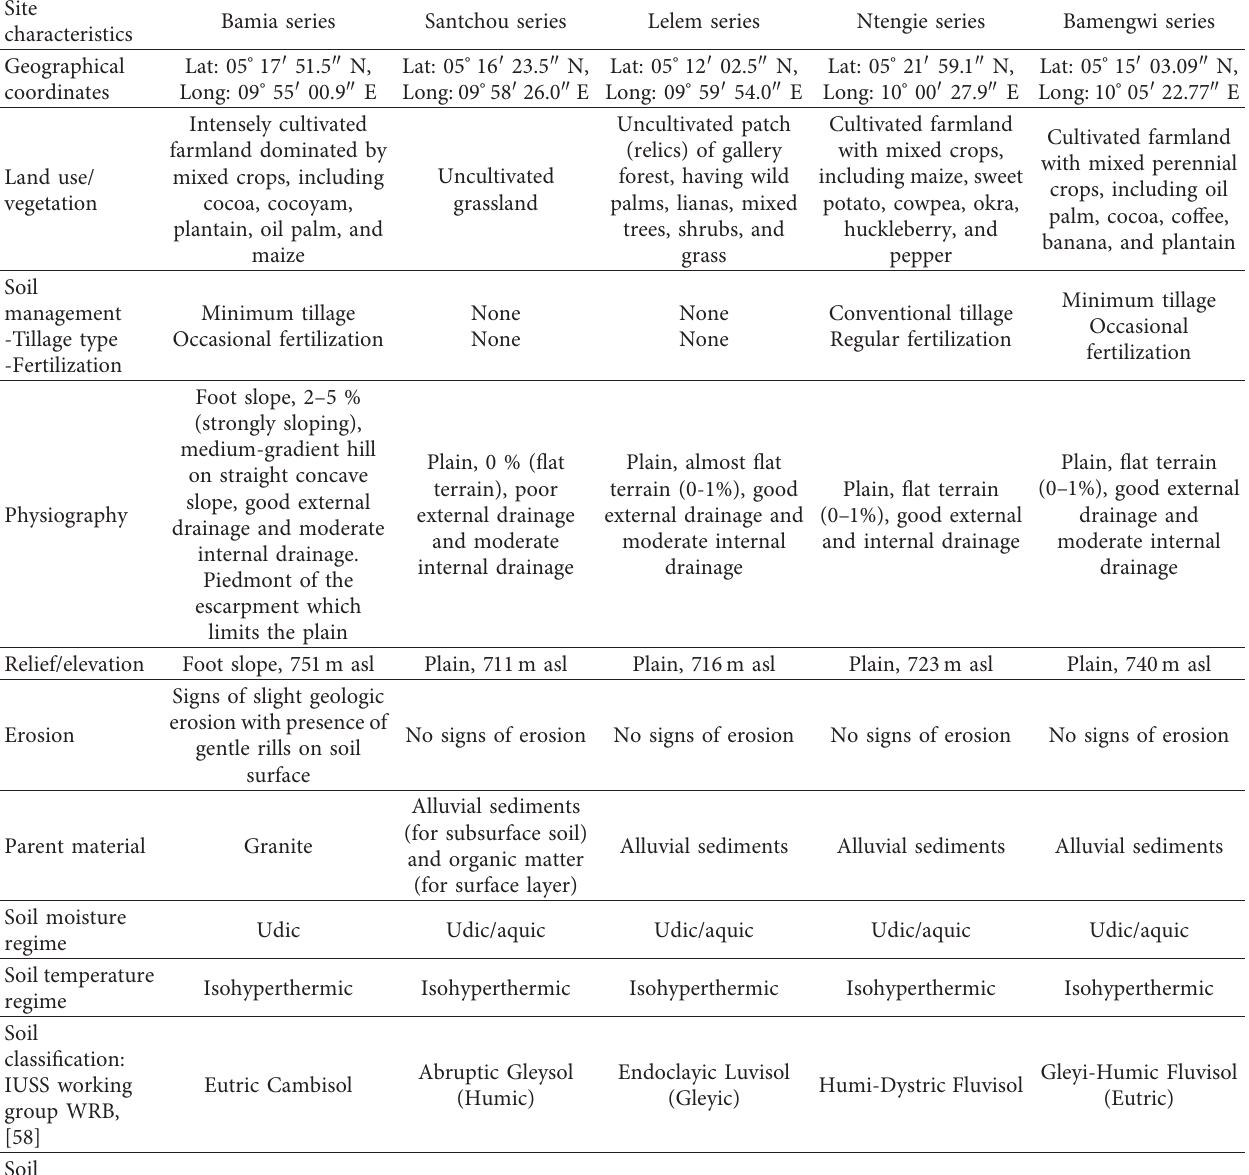
Table 2: Description of study sites and classification of representative soil